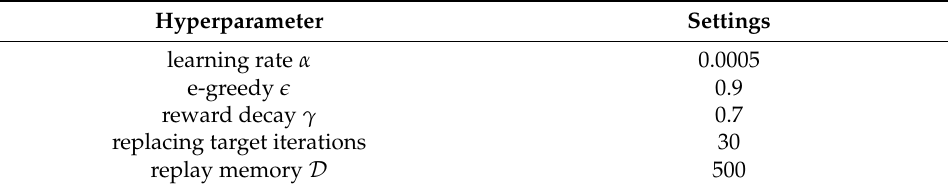
Table 3. Hyperparameter